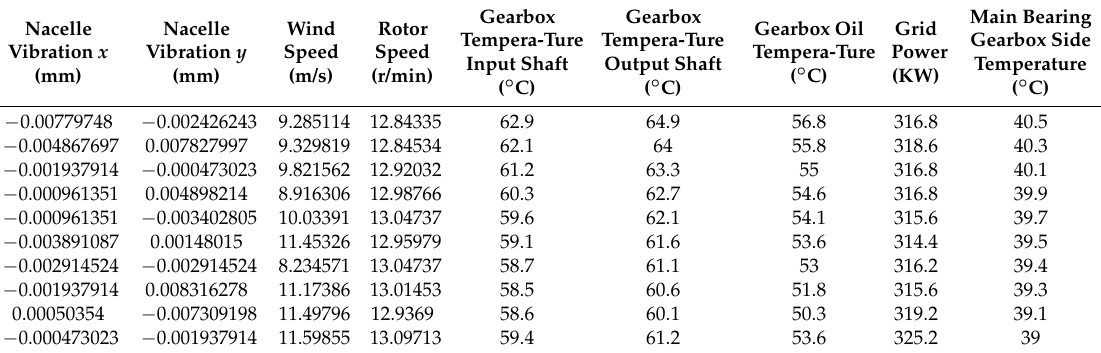
Table 2. Part of original sample data.